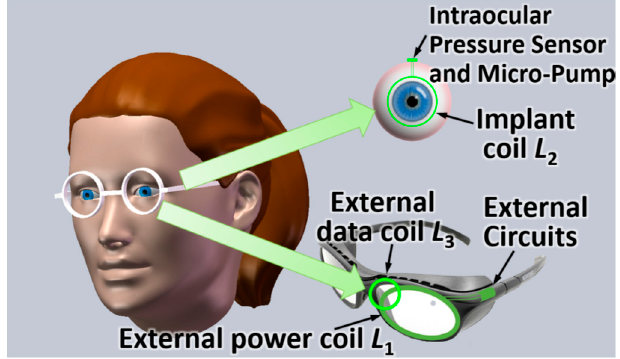
Figure 14. Proposed intraocular sensor system for glaucoma treatment [112]. Reproduced with permission from the corresponding author and MDPI Sensors.